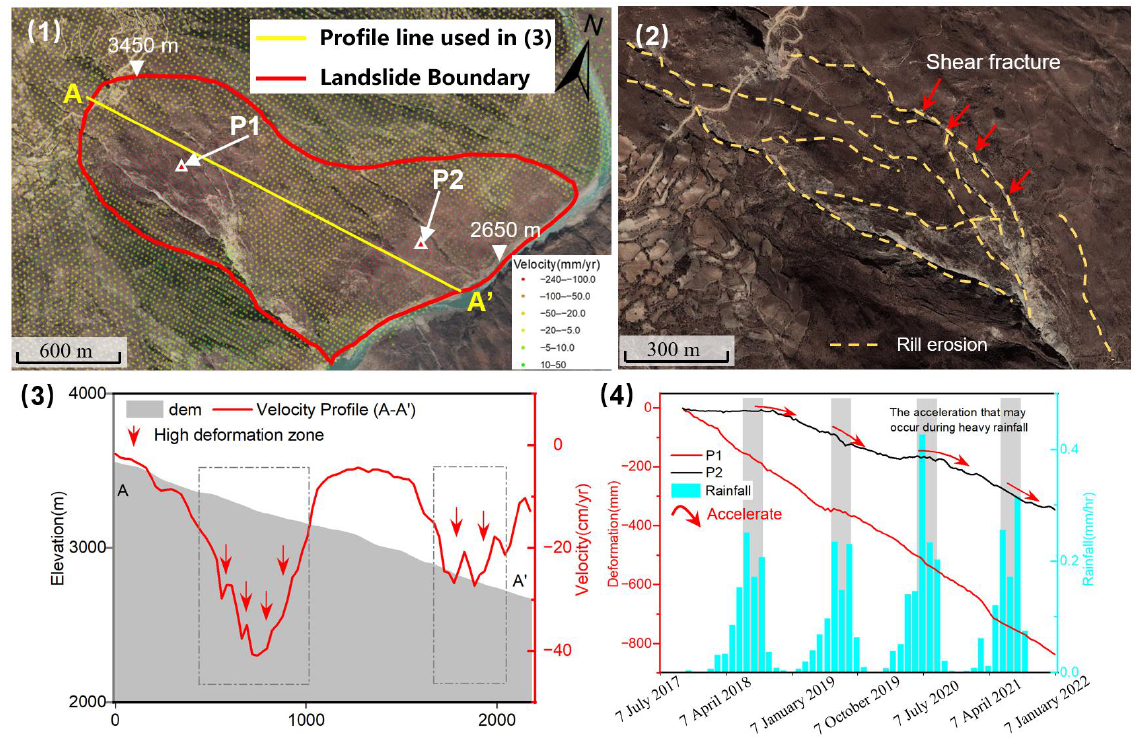
Figure 12. The Wadui landslide in Gongjue County and its deformation characteristics: ( 1 ) average velocity of the landslide acquired from SBAS-InSAR; ( 2 ) local Google Earth image; ( 3 ) deformation profile along A- A’ in (1) shows two large deformation regions; ( 4 ) relationship between monthly precipitation and points P1 and P2 time-series deformation.